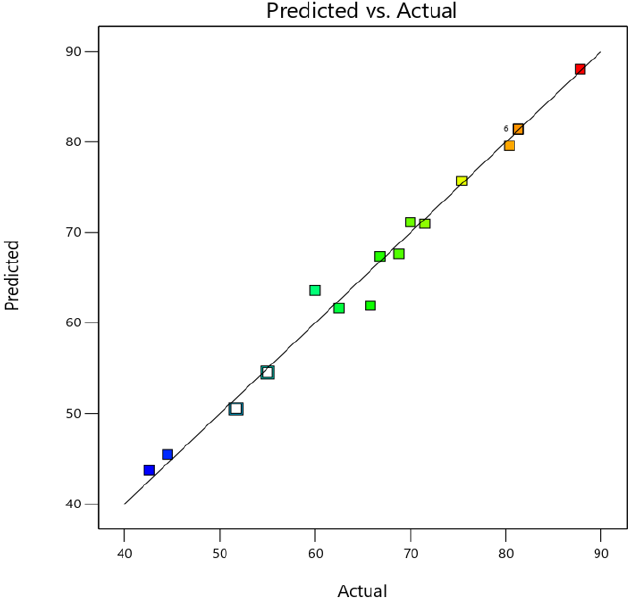
Figure 13. Diagnostic of predicted values vs. actual values for CIP removal %.